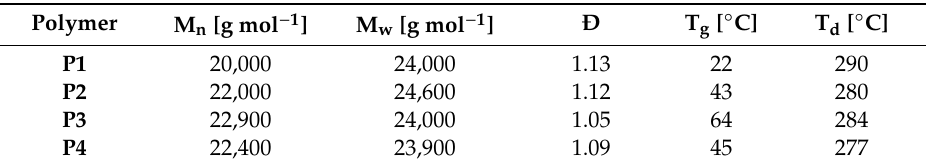
Table 1. Summary of the properties of the polymer P1 to P4 measured in size exclusion chromatography (SEC) (chloroform: isopropanol: trimethylamine; standard: poly(methyl methacrylate), di ff erential scanning calorimetry (DSC) and thermal gravimetric analysis